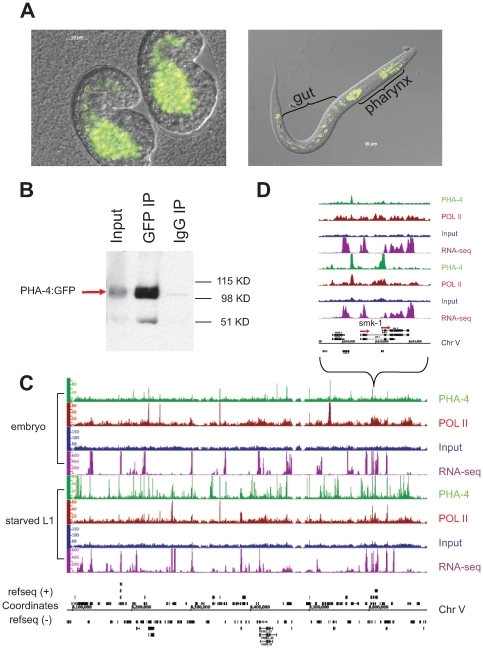
Identification of PHA-4 binding sites in embryos and starved L1 larvae.(A) PHA-4:GFP is expressed primarily in the pharynx and gut in embryos and L1s. (B) PHA-4:GFP is enriched upon immunoprecipitation by anti-GFP relative to input and is not immunoprecipitated by a control IgG antibody. (C) Signal tracks demonstrating specific PHA-4:GFP binding sites on chromosome V. Green track – PHA-4:GFP (GFP antibody); maroon track – RNA Pol II (8WG16 antibody); blue track – input control; purple track – mapped reads from RNA sequencing data. Embryonic data set shown on top, L1 larval dataset shown below. (D) Close-up of smk-1 locus showing that PHA-4 binding changes between stages, although the gene appears to be expressed at both stages. Other examples of PHA-4 binding are shown in Figure S5.